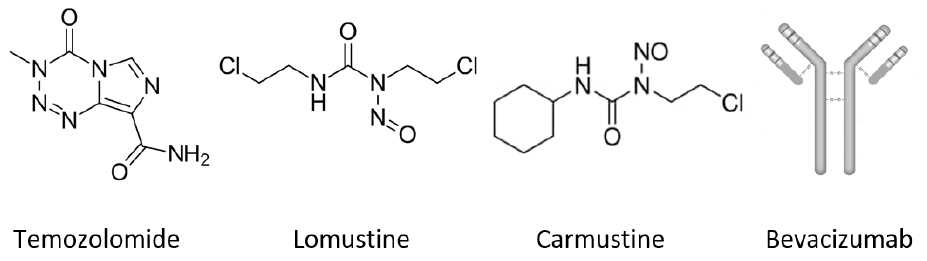
Figure 1. First ‐ line (TMZ) and second ‐ line (lomus, carmustine and BVZ) drugs for glioblastoma